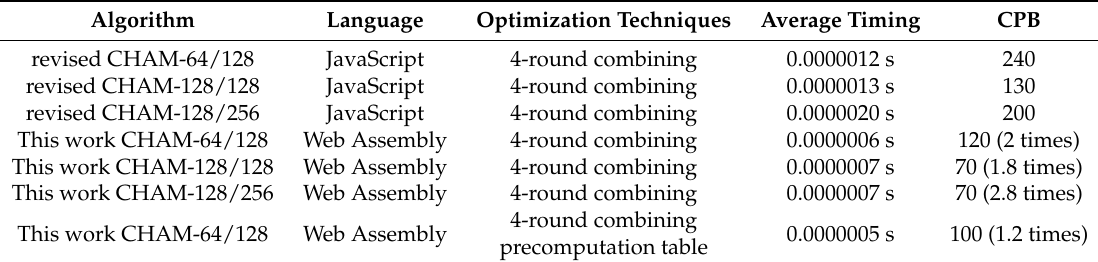
Table 12. Revised CHAM algorithm performance in Microsoft Edge (CPB : Cycle Per